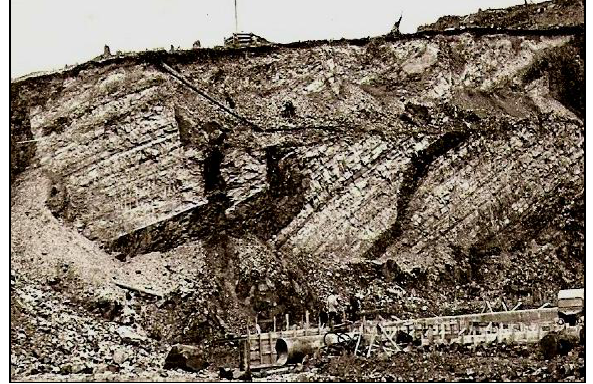
Fig. 2. The front side of the Trappean landslide block in the area of Badarma narrowing ( V. F. Osadcheva )